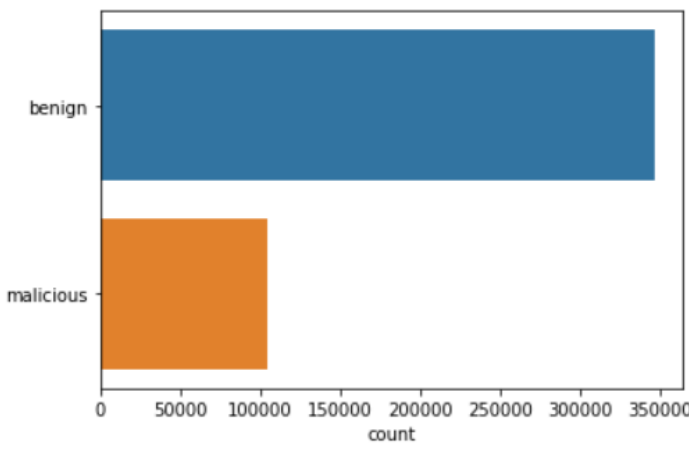
Figure 5. Length of malicious and legitimate URLs.